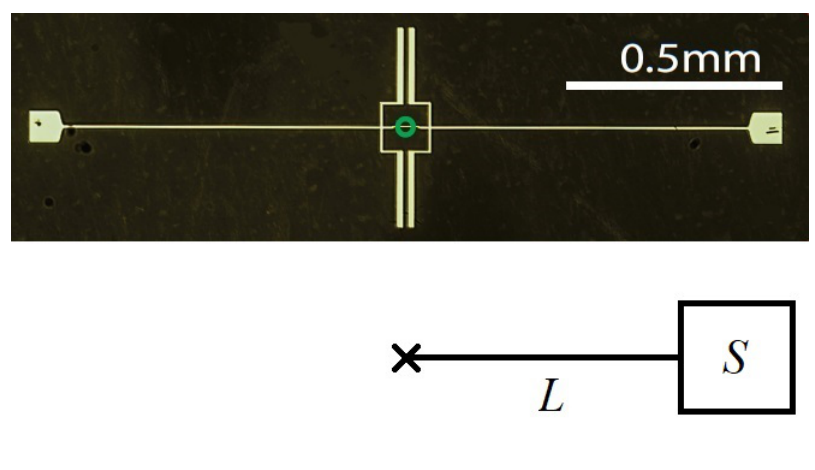
Figure 8: Top: (adapted from Ref. [ 30 ] ) Optical image of a qubit used to measure quasiparticle trapping due to vortices. Bottom: schematic diagram of the simplified model used in the text to calculate the quasiparticle density decay rate; it represent one half of a symmetric device with a wire of length L attached to a pad of area S